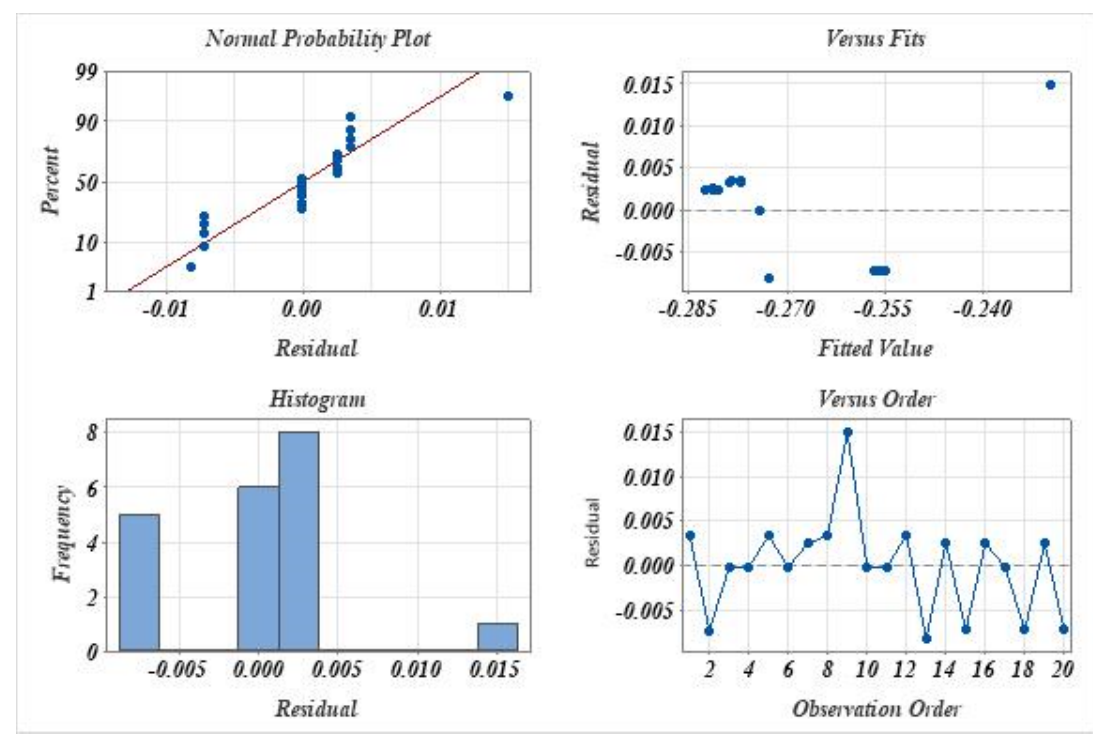
Figure 25. Plots of residual.